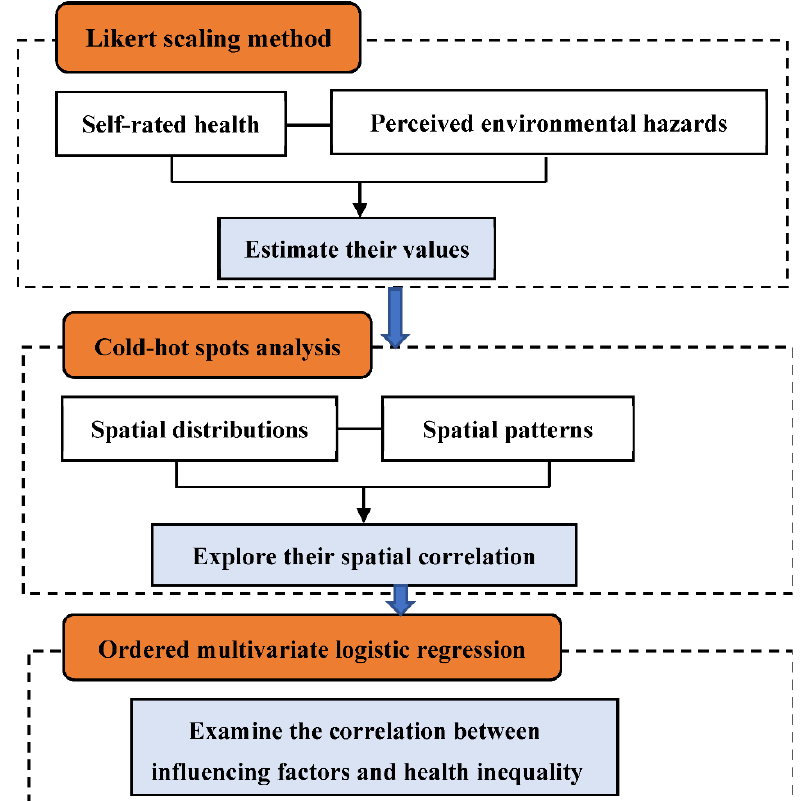
Figure 2. The method framework in this